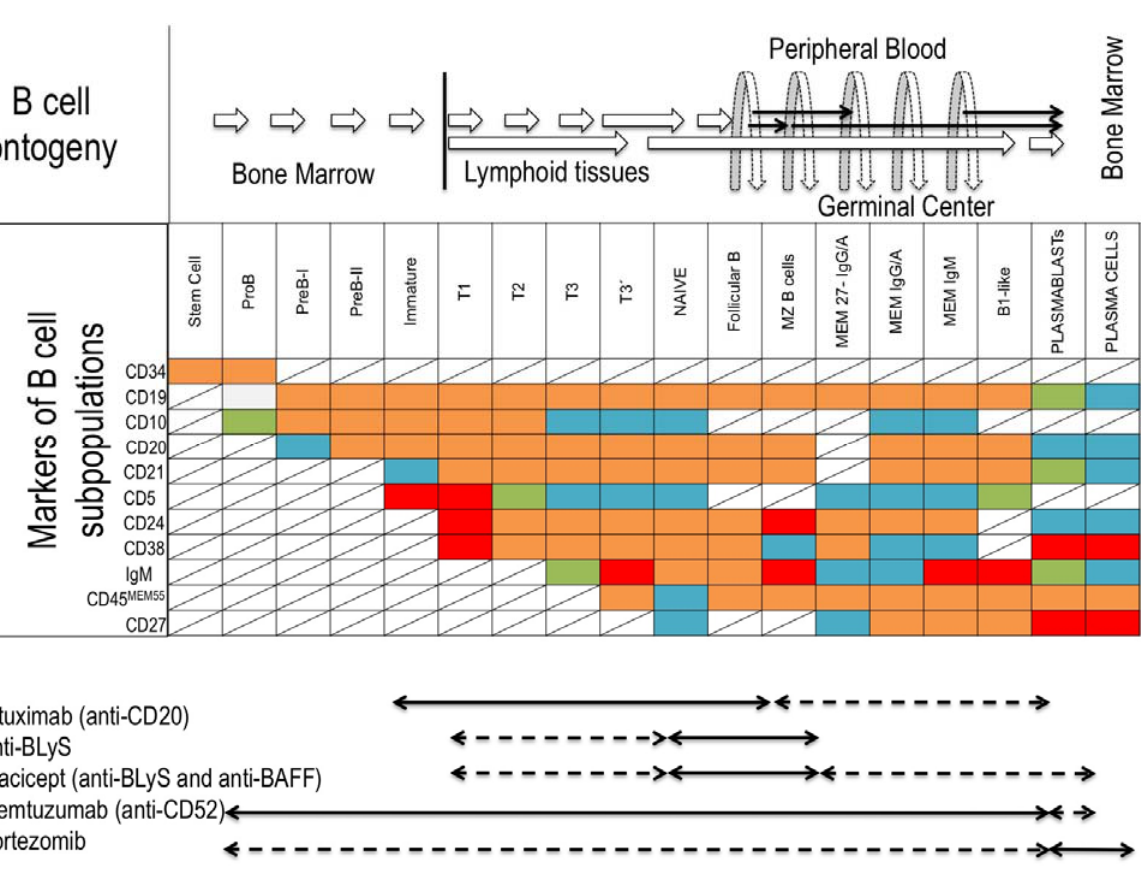
Figure 2. B-cells ontogeny, markers of B-cell subpopulations and monoclonal antibody treatment susceptibility. ( Top ) Origin and development pathways of B-cell subsets and localization in the peripheral tissues. ( Middle ) Different markers of B-cell subsets regarding maturational stage: background red (high expression); orange (medium expression), green (low expression); blue (no expression); line crossed (not defined). ( Bottom ) Antibody treatments targeting the B-cell compartment; susceptible subpopulation (black arrow); intermediate susceptibility (striped arrow). Abbreviations: T, transitional;